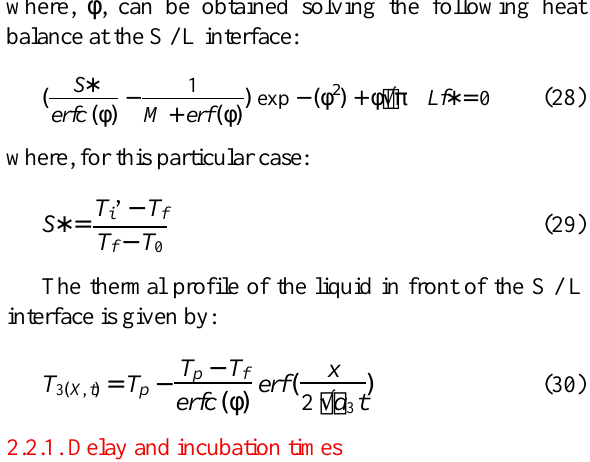
Figure 3. Influence of the incubation time t 0 on the Delay time (t 2 - t 1 ) and on the equations describing the L / L and S / L interfaces propagation inside a metal ingot during